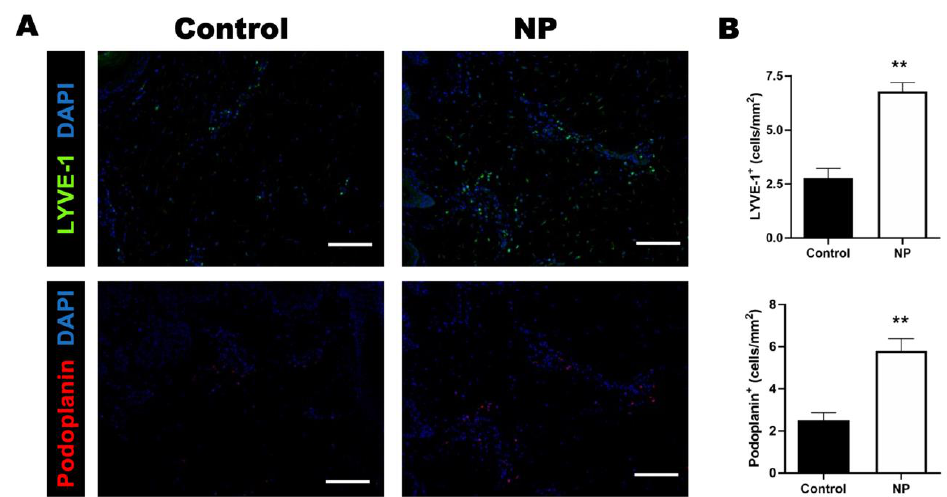
Figure 7 . The numbers of LYVE-1 and podoplanin cells increased in the NP group. ( A ) Immuno- histological staining of LYVE-1 (green) and podoplanin (red) in the control and NP groups. ( B ) The quantification of LYVE-1- and podoplanin-labeled cells in the control and NP groups (n = 4). Scale bar: 200 µm. ** p < 0.01. Error bar: standard error.